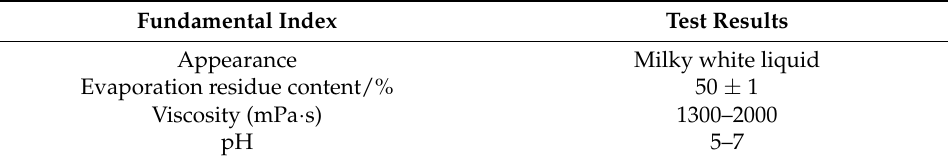
Table 2. Properties of epoxy resin SBR.